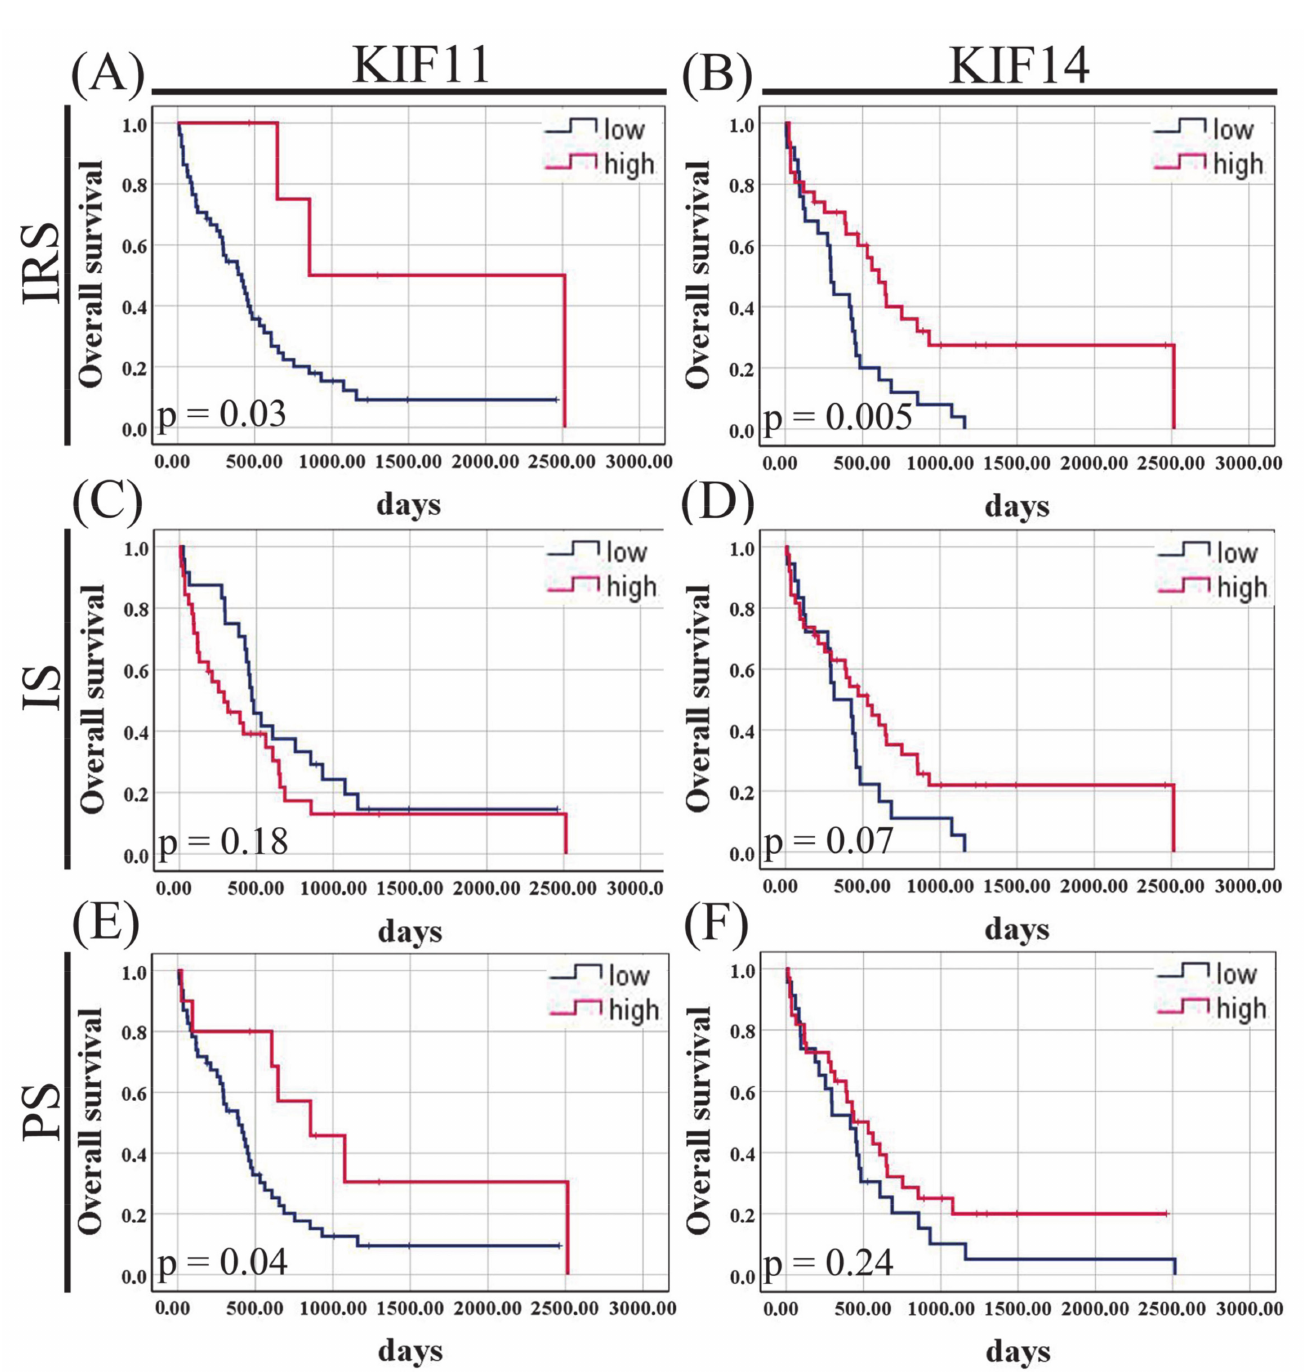
Figure 3. Kaplan—Meier curves for overall survival of pancreatic ductal adenocarcinoma patients stratified by KIF11 ( A , C , E ) or KIF14 ( B , D , F ) immunoexpression. IS—immunointensity; PS—immunopercentage; IRS—immunoreactive score. p -Values were calculated using the log-rank